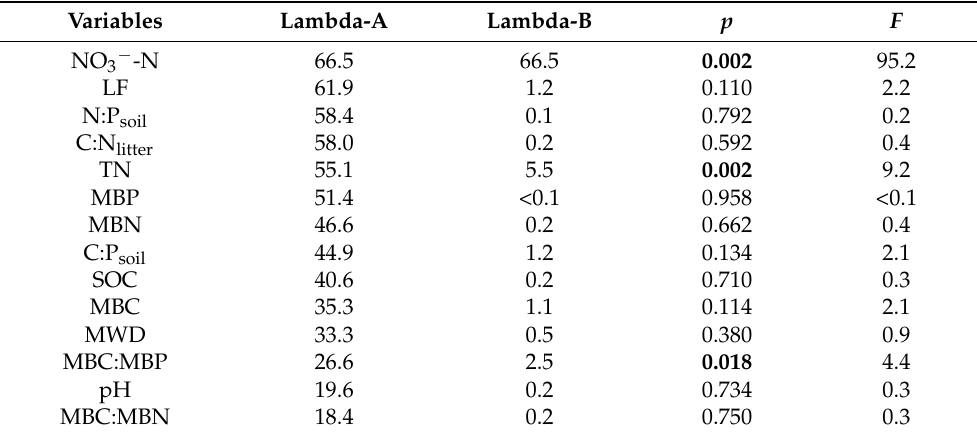
Table 4. Simple and conditional effects of environmental factors on soil extracellular enzymatic activity (EEA) identified in the redundancy analysis (RDA).